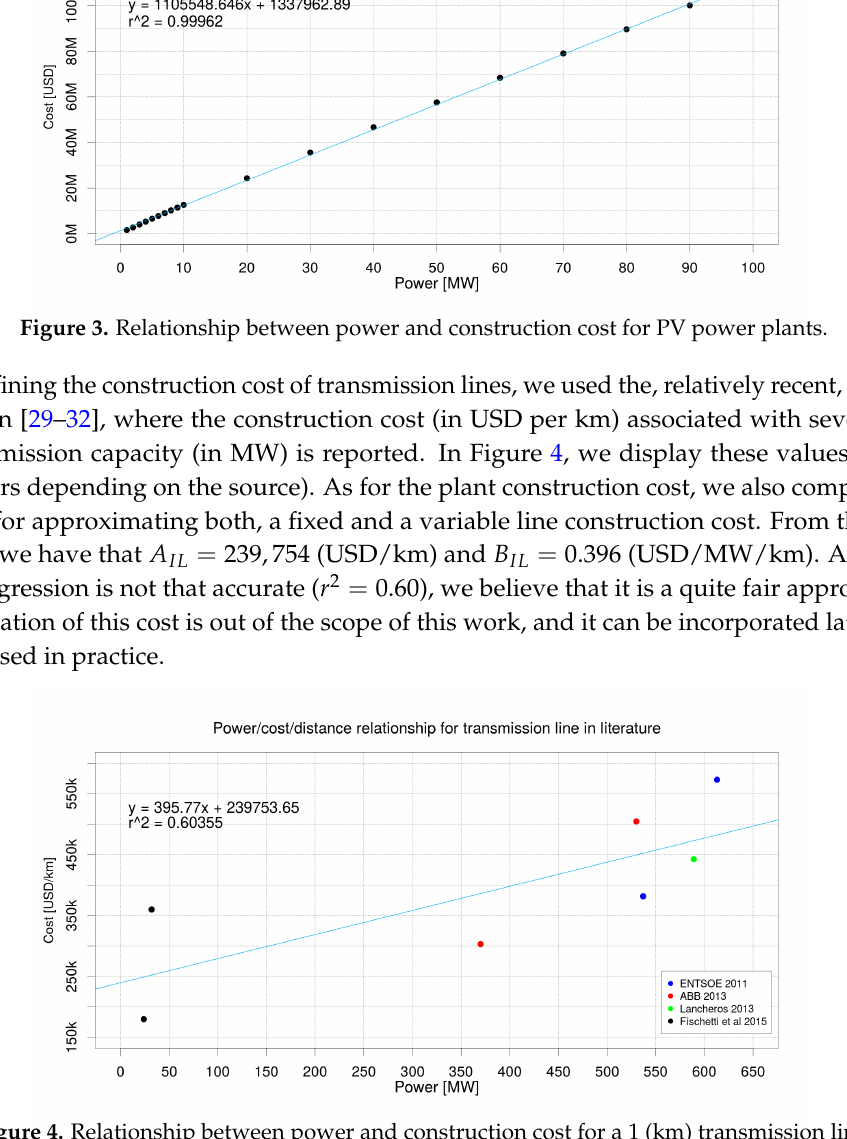
Figure 4. Relationship between power and construction cost for a 1 (km) transmission